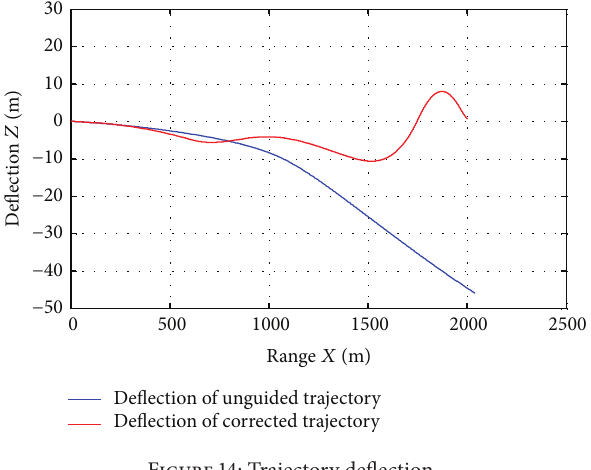
Figure 14: Trajectory deflection.